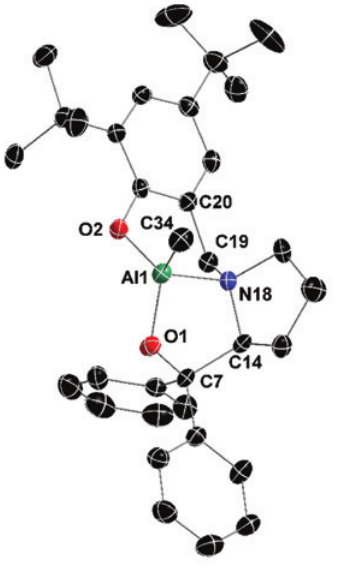
Figure 6: 1 H NMR spectrum (benzene- d Ga(CH SiMe ) at 343 K for 3 2 3 3